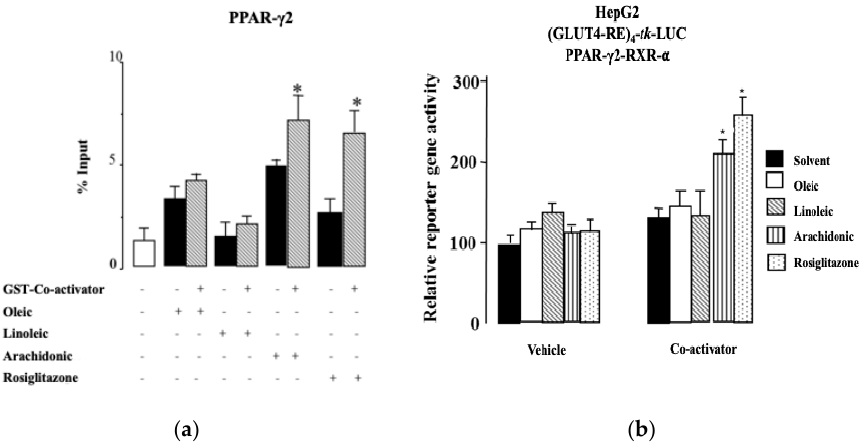
Figure 2. Ligand-dependent interaction profiles between the PPAR- γ 2 and co-activators on DNA. ( a ) In vitro experiment using GST-pull down assays with GST-SRC1597-791 (Co-activator) and [ 35 S]-labeled wild-type PPAR- γ 2 in the presence of the vehicle (DMSO) (1 µ M), 1 µ M OA, LA, and AA. As a positive control, we used rosiglitazone (1 µ M). The percentage of precipitated PPAR- γ 2 proteins with respect to the input was quantified. The columns represent means ± SEM of at least three experiments, and the data were analyzed by Student’s t test (* p < 0.05). Significative differences were denoted compared with the GST-SRC1 interaction in the presence of the ligands. ( b ) In vivo experiment using luciferase reporter gene assays to determine the basal and ligand-induced activity of PPAR γ -2. HepG2 cells were transiently transfected with a reporter construct containing human (GLUT4-RE) 4 -tk-LUC and the indicated expression vectors for PPAR γ -2, RXR α and SRC1 (co-activator). HepG2 cells were treated for 16 h with 10 µ M of the vehicle (DMSO), OA, LA, and AA as rosiglitazone (positive control) for PPAR γ -2. The stimulation of the luciferase activity was normalized to the basal activity of PPAR γ -2–RXR α in the absence of co-activators. The percentage of precipitated PPAR- γ 2 proteins with respect to the input was quantified. The columns represent means ± SEM of at least three experiments, and the data were analyzed by Student’s t test (* p < 0.05). Significant differences were denoted compared with the GST-SRC1 interaction in the presence and absence of ligands. Abbreviations: PPAR- γ 2: peroxisome proliferator-activated receptor gamma type 2; GST: glutathione S-transferase; GST-co-activator or GST-SRC1: glutathione S-transferase-tagged steroid receptor coactivator 1-receptor interaction domain 597 791; DMSO: dimethyl sulfoxide; GLUT4: glucose transporter type 4; HepG2: liver hepatocellular carcinoma cell line; (GLUT4-RE) 4 -tk-LUC: GLUT4 reporter fused with thymidine kinase luciferase activity; RXR: retinoid X receptor; OA: oleic acid; LA: linoleic acid; and AA: arachidonic